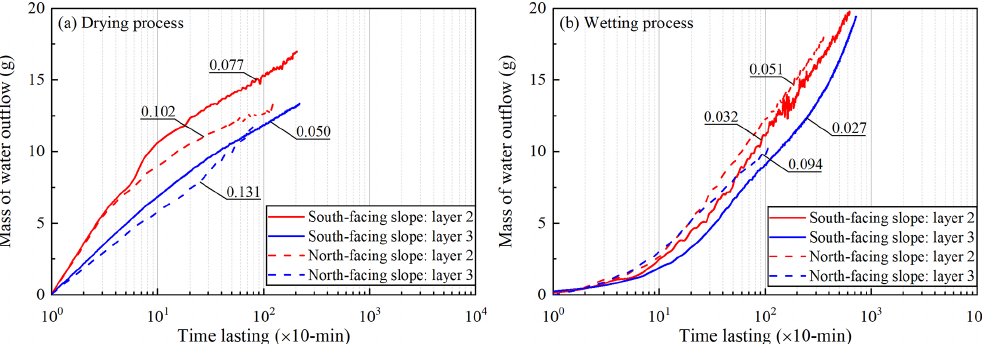
Figure 7. Mass of water outflow during the drying and wetting process, including (a) drying tests and (b) wetting tests. The mass of water outflow was recorded at 10min for each